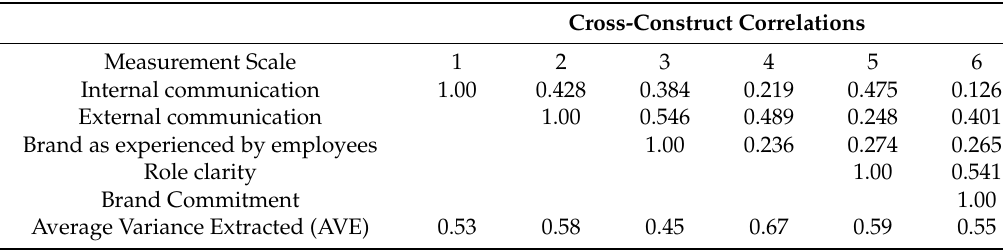
Table 2. Construct correlations and Average Variance